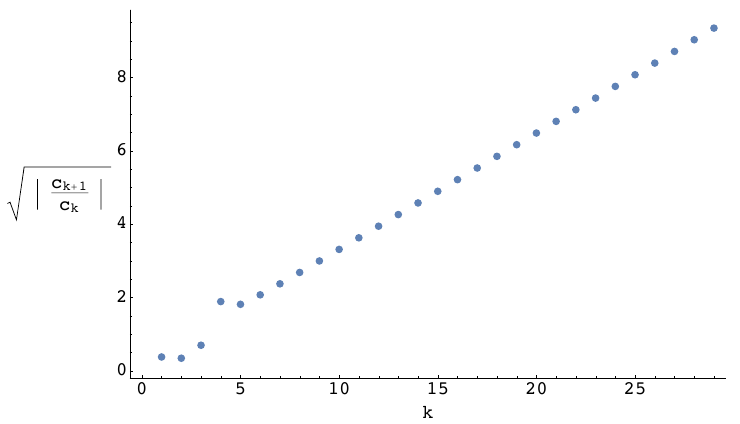
j (cid:24) k 2 for large k . c k